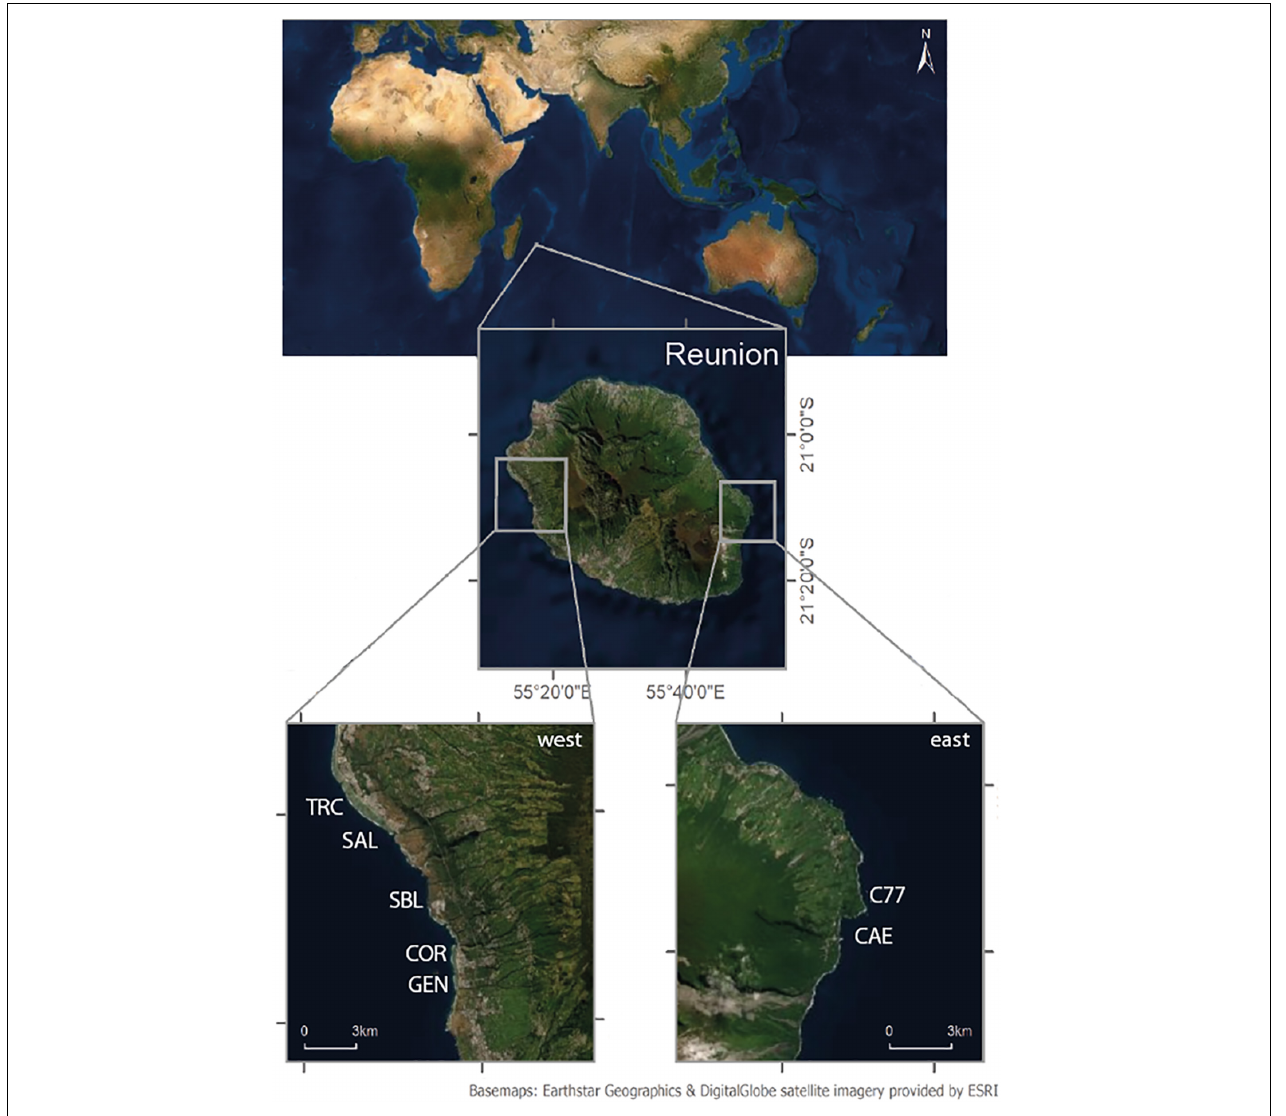
FIGURE 1 | Map of the study sites. On the west coast: TRC, SAL, SBL, COR and GEN. On the east oast (lava-flow reefs): C77 and